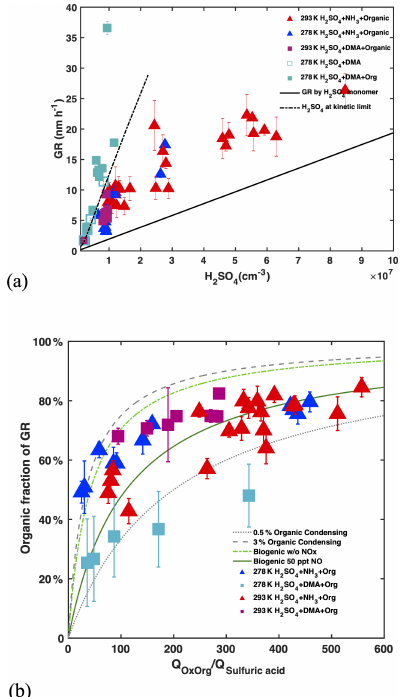
Figure 4. Influence of sulfuric acid, OxOrg and DMA on growth rate (GR): (a) GRs are measured between 1.8 and 3.2nm, at 278K (blue and cyan) or 293K (red and magenta) with 1 to 2ppbv NH 3 and plotted versus sulfuric acid monomer concentration. GRs with- out DMA injection are shown by triangles and GRs with 4pptv DMA by squares. Filled and open symbols indicate presence or ab- sence of organics, respectively, where the variability of the filled symbols is mostly driven by the concentrations of oxidized organics (OxOrg) and NO x . The solid line shows GR for the condensation of the sulfuric acid monomer only while the dashed line displays sulfuric acid nucleating at the kinetic limit, when cluster coagula- tion dominates the growth. (b) Contribution of oxidized organics (OxOrg) to sub-3nm GR (determined by subtracting GR by sulfu- ric acid) as a function of the ratio of the production rates of ox- idized organics ( Q OxOrg ) to sulfuric acid ( Q sulfuricacid ). This ra- tio is roughly proportional to the ratio of condensable organics to sulfuric acid in the CLOUD chamber. The grey lines encompass most data and indicate that 0.5% (dotted) to 3% (dashed) of the total oxidized organics contribute to the growth of sub-3nm parti- cles. With the exception of sulfuric acid + DMA at 278K, organ- ics are the dominant contributor to particle growth in the sub-3nm size range. At larger particle sizes, the contribution of organics will increase further (Tröstl et al., 2016). Data are compared to the pa- rameterizations of monoterpene oxidation by Lehtipalo et al. (2018) where the dark green line shows a strong decrease in the yield of condensable gases in the presence of only 50pptv NO compared to the light green dashed–dotted line for conditions without NO. Condensable OxOrg yields are generally higher from AVOCs than those obtained from biogenic vapours such as monoterpenes at ele- vated NO x conditions (green lines), again consistent with the lower volatility of aromatic OxOrg formed by multi-generation oxidation in comparison with biogenic (monoterpene) OxOrg with the same oxygen content (Wang et al.,